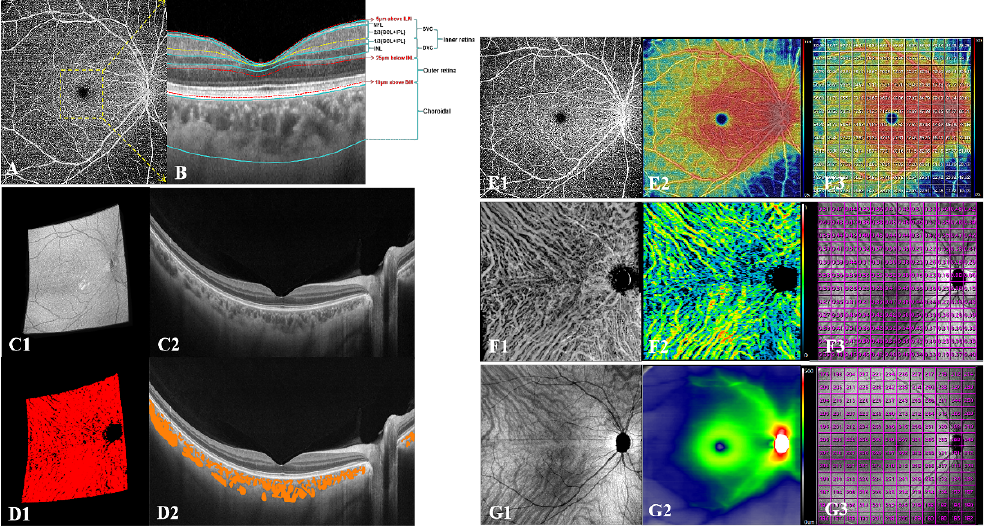
Figure 3. SS-OCTA imaging and quantification. ( A ) 12 mm × 12 mm SS-OCTA scanning. ( B ) 3 mm × 3 mm OCT image of the yellow square in ( A ). Blue, red, and yellow curves represent segmentation layers. ILM, internal limiting membrane; NFL, nerve fiber layer; GCL, ganglion cell layer; IPL, inner plexiform layer; INL, inner nuclear layer; BM, Bruch’s membrane; SVC, superficial vascular complex; DVC, deep vascular complex. ( C1 – D2 ) 3D CVI pictures derived using built-in techniques. The orange areas in ( D2 ) represent choroidal vascular luminal areas in one B-scan layer. ( D1 ) shows the synthesized choroidal vascular luminal volume, which was derived from 1024 B-scans (such as ( D2 )). ( E1 – G1 ) The raw images of VD, CVI, and retinal thickness. ( E2 – G2 ) The color-coded maps of VD, CVI, and retinal thickness. ( E3 – G3 ) The mean VD, CVI, and retinal thickness presented in 1 × 1 mm grids. SS-OCTA, swept-source optical coherence tomography angiography; OCT, optical coherence tomography; 3D CVI, three-dimensional choroidal vascularity index; VD, vessel